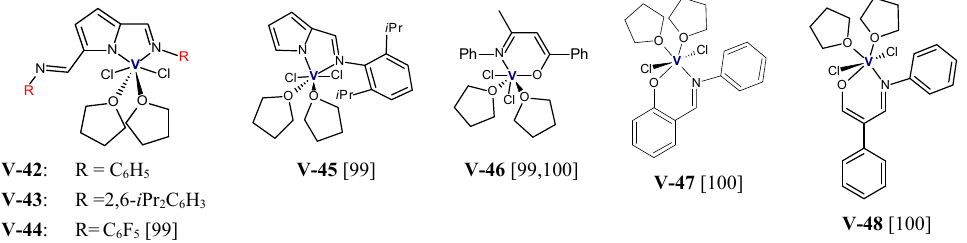
Figure 9. Vanadium complexes investigated as precatalysts for ethylene/ α , ω -alkenols copolymerization [99,100]. Table 7. Ethylene/ α , ω -alkenols copolymerization results.